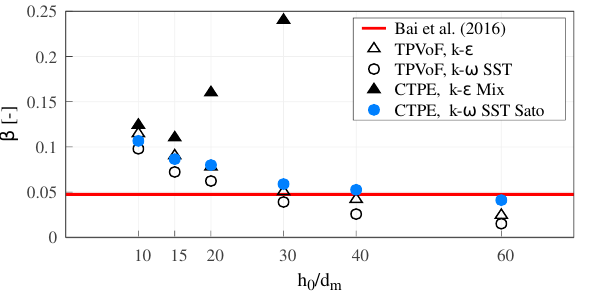
Figure 5. Lower-nappe aeration: ratio β between the flow-rate of air-entrained at the cavity zone and water flow-rate, for distinct mesh